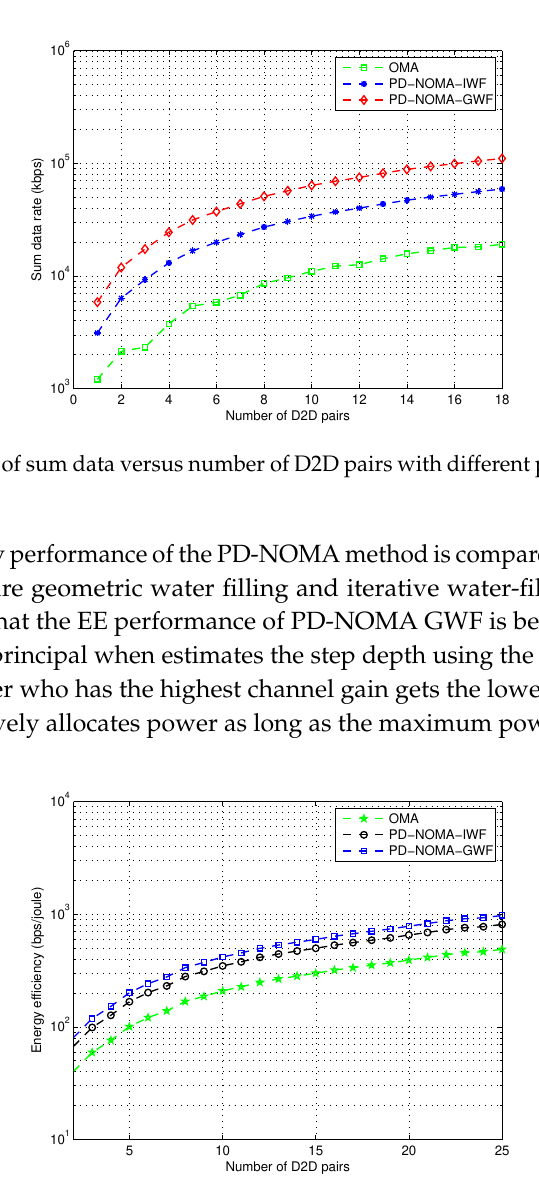
Figure 6. Energy efficiency performance versus number of D2D pairs when C =